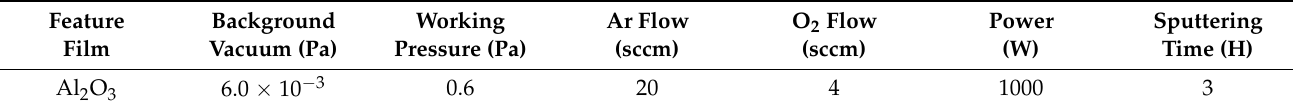
Table 1. Preparation process parameters of Al 2 O 3 insulating film.